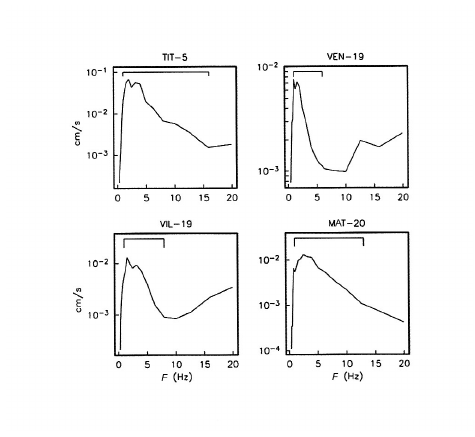
Fig. 3. The geographical form of the 1st precipitation principal component. The contours represent equal com- ponent loading values and indicate that the regions of maximum variability occur towards the west and south- east extents of the Mediterranean. The smooth contours were drawn by fitting a lowess smoothing function (Cleveland, 1979) to the loadings of the first principal component. Black dots represent the forty-four precipita- tion recording stations used in the